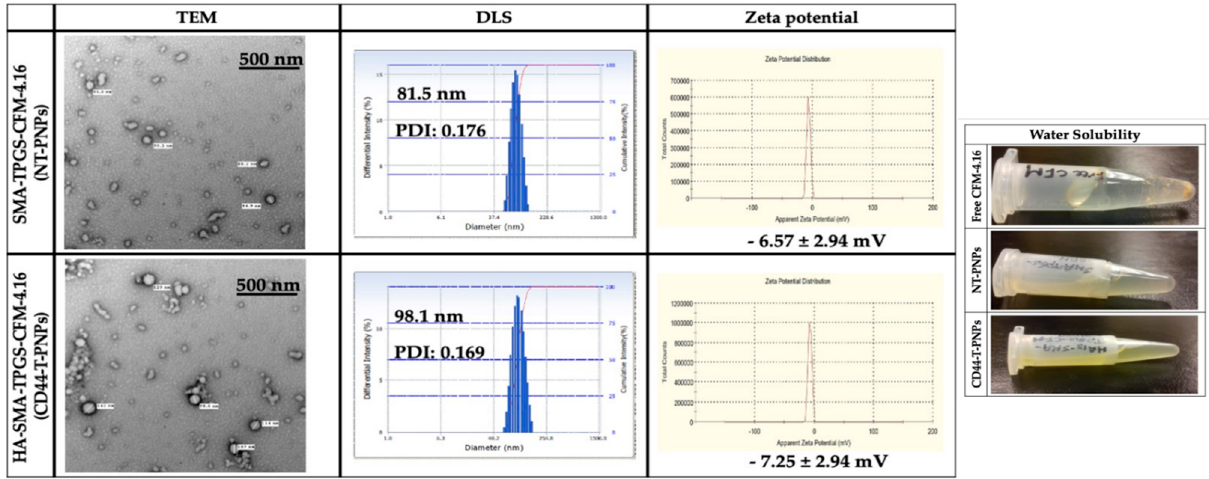
Figure 3. Nanoparticle characterization. Particle characterization including morphology by TEM with 500 nm scale bar, hydrodynamic size by DLS, zeta potential by zeta sizer and water solubility. Both NT-PNPs and CD44-T-PNPs are completely water soluble that enable their parenteral administration compared to non-soluble free CFM-4.16.